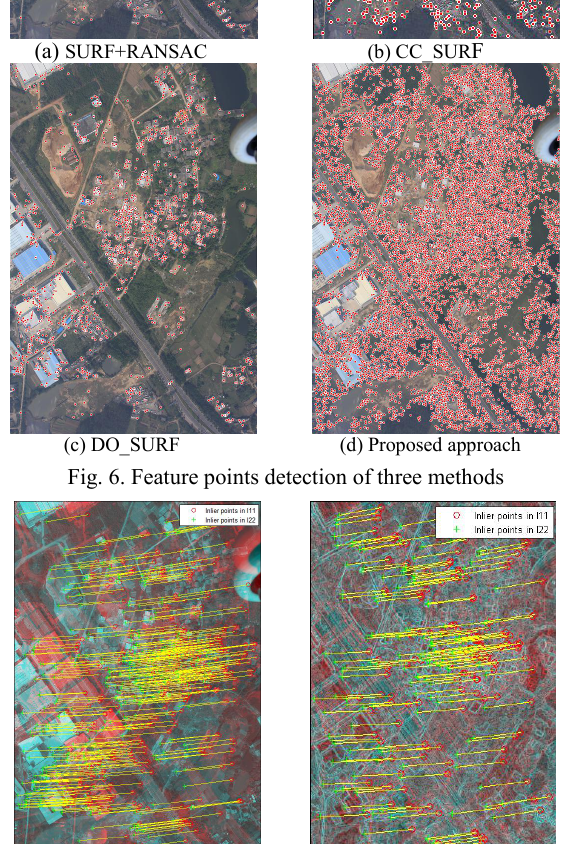
Fig. 5. Original images (Zheng et al., 2015)